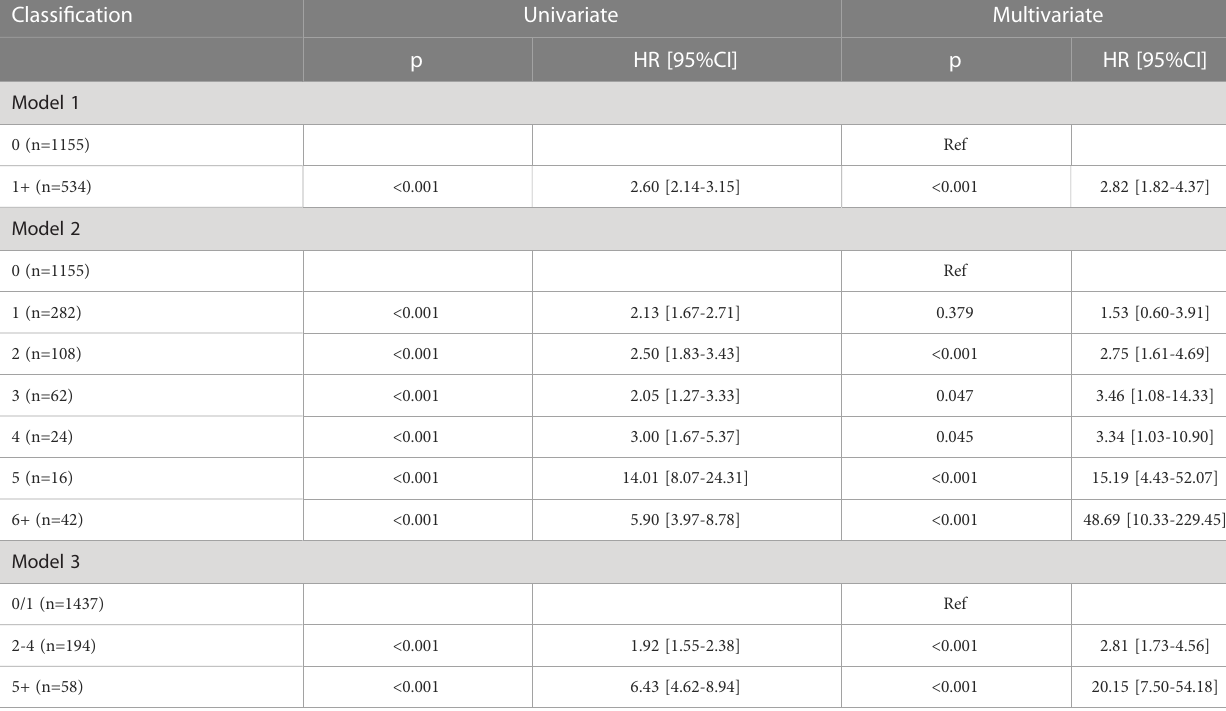
TABLE 3 Univariate and multivariate Cox analysis of the impact of number of positive lymph nodes on disease speci fi c survival.